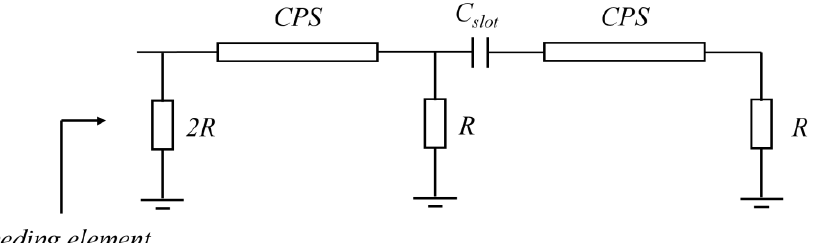
Figure 5. The equivalent circuit for the half structure of 1-D 5 × 1 interconnected ME dipole array with slot.